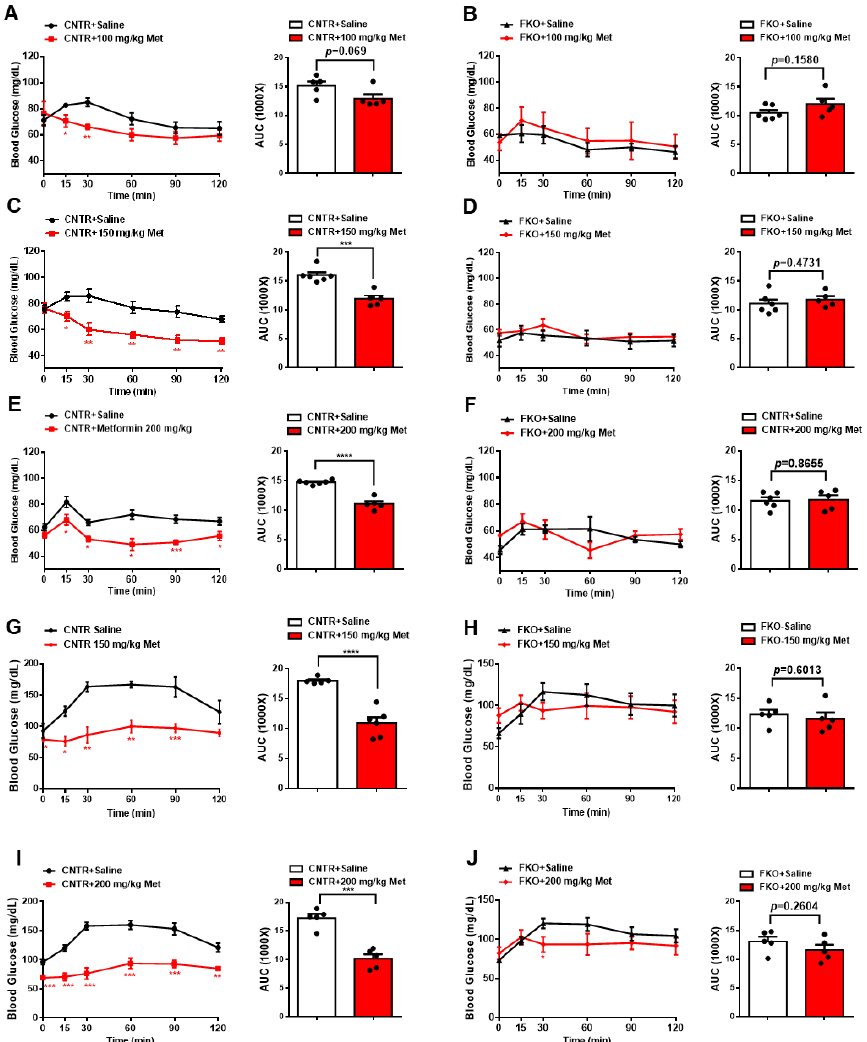
Figure 2. Metformin suppresses blood glucose in mice through hepatic Foxo1 gene. ( A , B ) 100 mg/kg body weight metformin (Met) was acutely i.p. injected into control ( A )and FKO ( B ) mice. Blood glucose was monitored at indicated time points, n = 5–6 mice/group. ( C , D ) 150 mg/kg body weight metformin (Met) was acutely i.p. injected into control ( C ) and FKO ( D ) mice. Blood glucose was monitored at indicated time points, n = 5–6 mice/group. ( E , F ) 200 mg/kg body weight metformin (Met) was acutely i.p. injected into control ( E ) and FKO ( F ) mice. Blood glucose was monitored at indicated time points, n = 5–6 mice/group. ( G , H ) 150 mg/kg body weight metformin (Met) was acutely i.p. injected into control ( G ) and FKO ( H ) mice after 16 h fasting. After 45 min, pyruvate tolerance test was performed, n = 5–6 mice/group. ( I , J ) Control ( I ) and FKO ( J ) mice were fasted for 16 h and then i.p. injected with 200 mg/kg body weight metformin. After 45 min, pyruvate tolerance test was performed, n = 5 mice/group. All data are presented as mean ± SEM. *** p < 0.001, **** p <0.0001. CNTR: